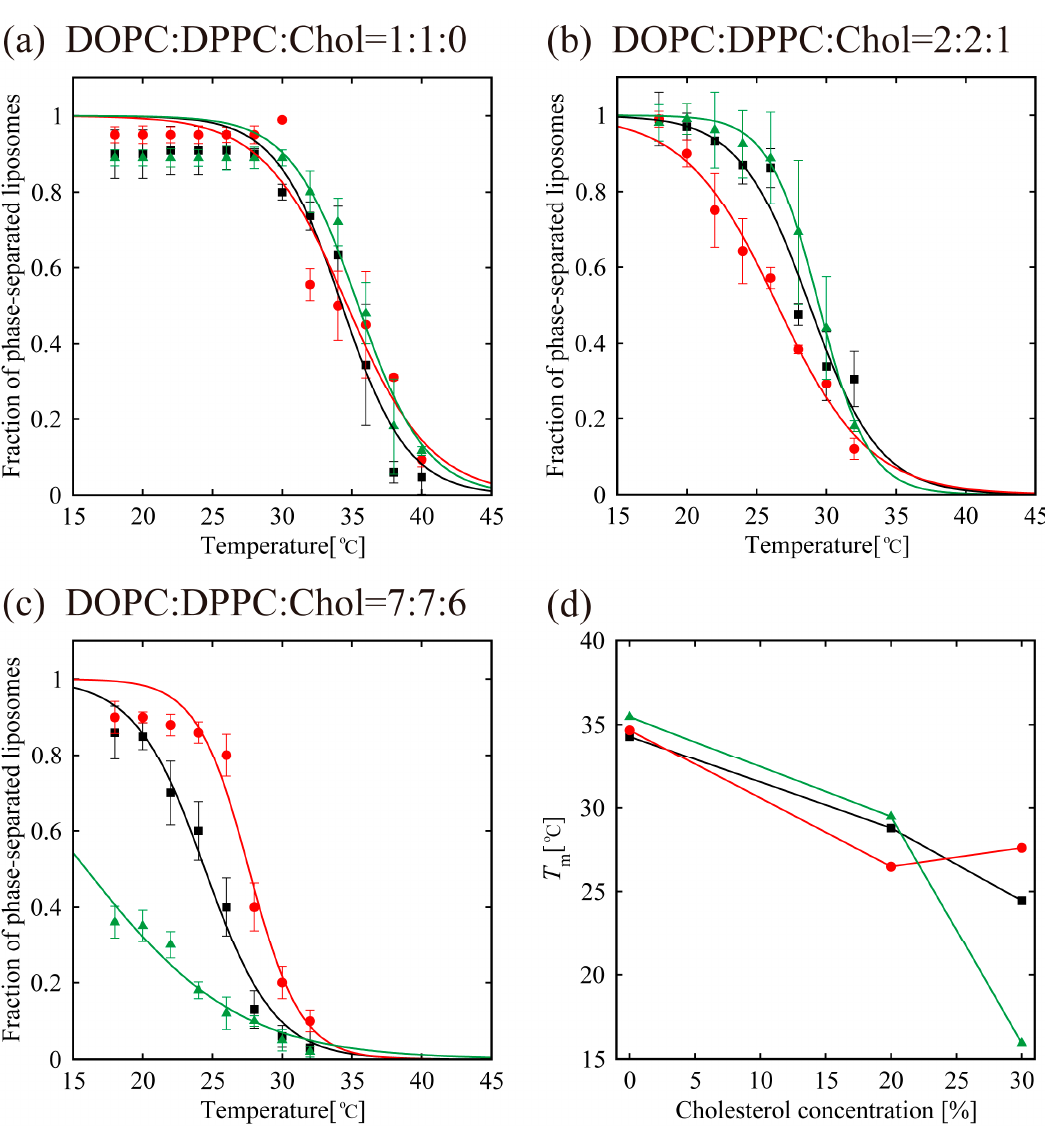
Figure 5. Miscibility temperature measurement for DOPC/DPPC/Chol/menthol systems. We fixed DOPC:DPPC:Chol = 1:1:0 in ( a ), DOPC:DPPC:Chol = 2:2:1 in ( b ), and DOPC:DPPC:Chol = 7:7:6 in ( c ). The mole fraction of menthol is 10%. Black lines and black squares indicate DOPC/DPPC/Chol without menthol. Red lines with red circles and green lines with green triangles are DOPC/DPPC/Chol with d-menthol and l-menthol, respectively. ( d ) The change in the miscibility temperature as a function of Chol concentration in lipids, defined as [Chol]/([DOPC]+[DPPC]+[Chol])%.